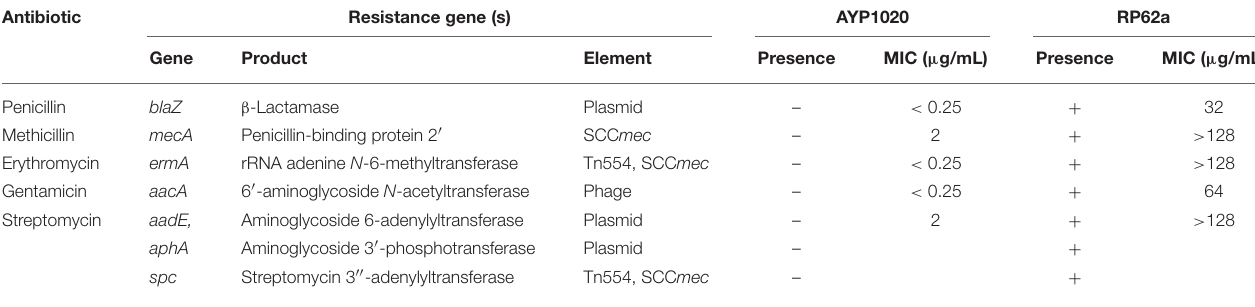
TABLE 2 | Comparison of antibiotic resistance profiles of S. capitis AYP1020 and S. epidermidis RP62a and their associated mobile elements.